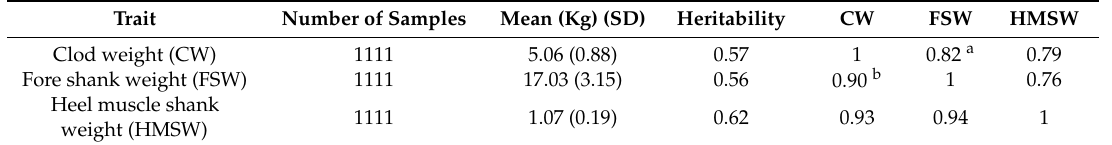
Table 3. Statistical summary and genetic parameters of three phenotypes.